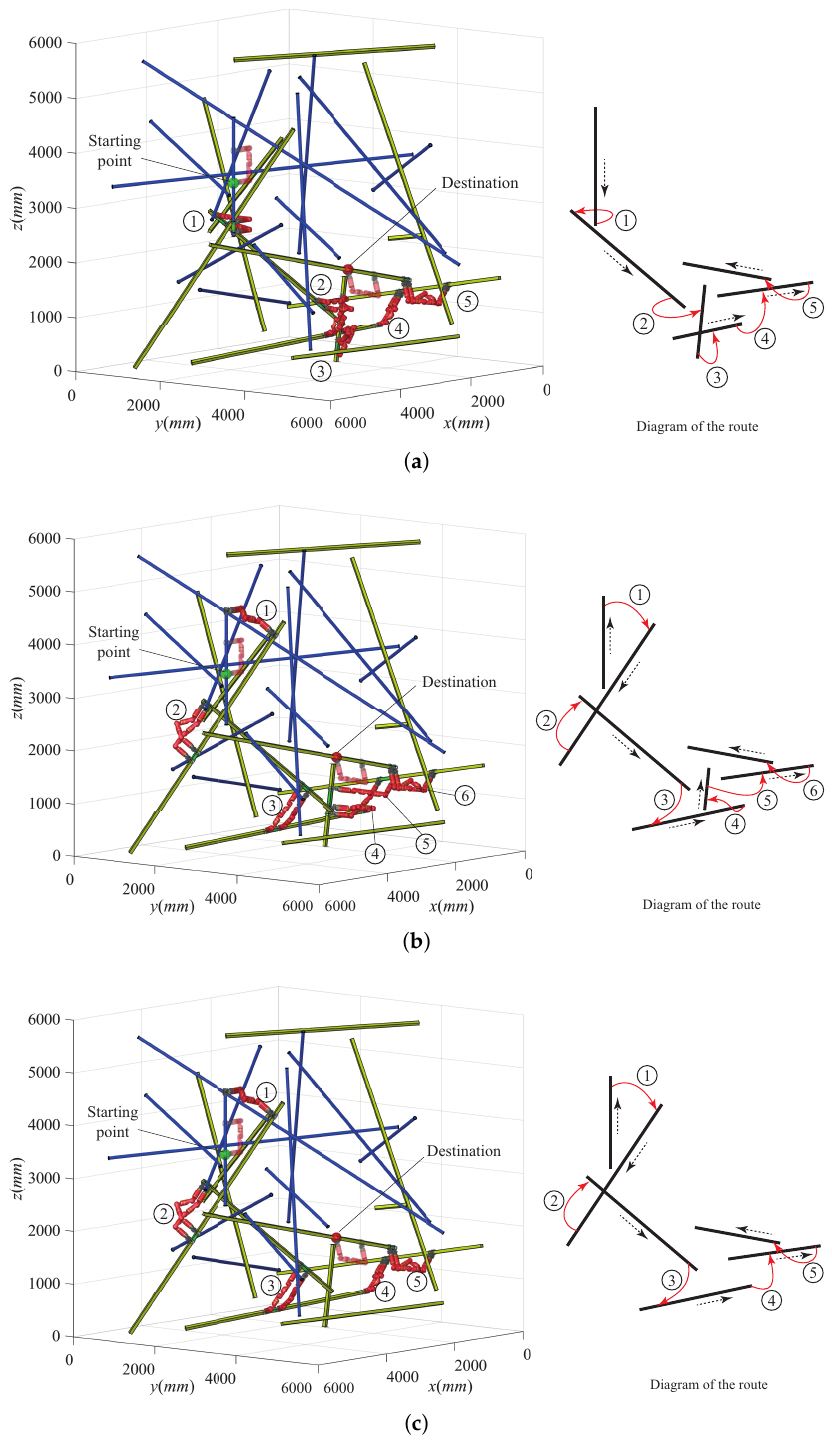
Figure 10. Results of global path determination in Scene II consisting of 25 members. ( a ) Route I; ( b ) Route II; ( c ) Route